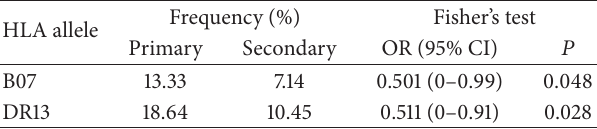
Table 3: Results of one-sided Fisher’s test (OR < 1) of association between the various HLA alleles analyzed and the type of dengue infection (primary versus secondary